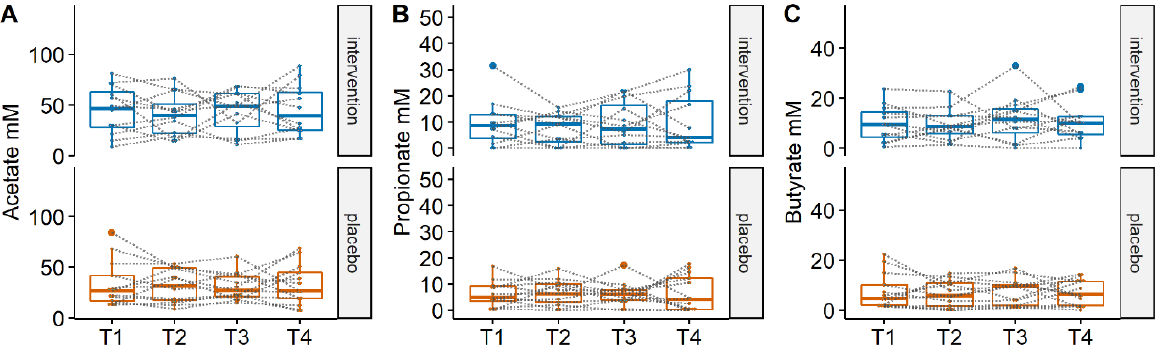
Figure 3. Concentrations of the SCFAs ( A ) acetate, ( B ) propionate and ( C ) butyrate detected in the fecal water of the samples in the two groups. No significant differences were detected between the two groups. The boundaries of the box on the bottom indicate the 25th percentile, the line within the box represents the median, and the boundary of the box on the top the 75th percentile, and data from individual participants are connected by dotted lines. Differences between groups and within groups were calculated using Linear mixed effects models.